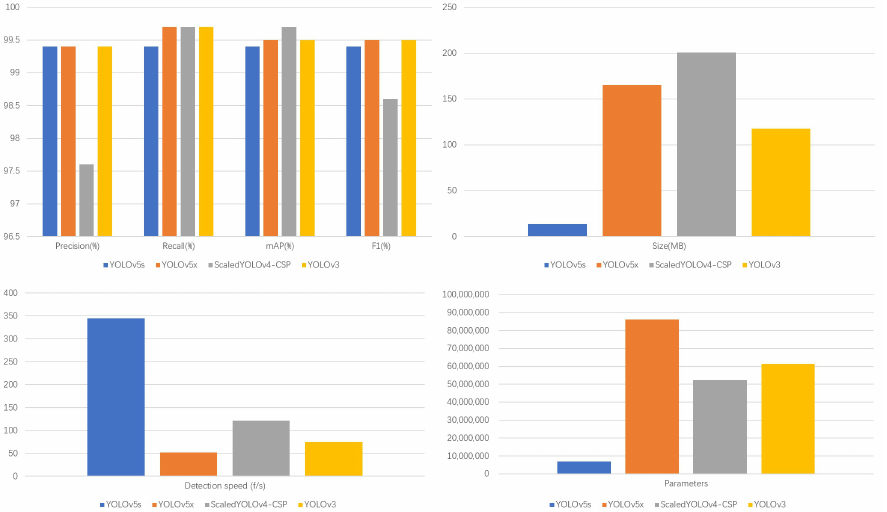
Figure 8. Performance comparison of four end-to-end object detection networks for grape cluster